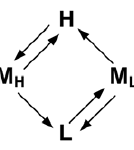
Figure 7. Four-state model characterizing KKRR-ShPrP(120– 232) kinetics in the pore. H, M H , L, and M L refer to the high, mid- high, low, and mid-low states respectively (N.B. PrP C can escape from the pore from each state, which is not explicitly shown in the four-state model). HMM analysis of KKRR-ShPrP(120–232) in combination with the mid-state analysis (refer to text) yields the information on how the states are connected.